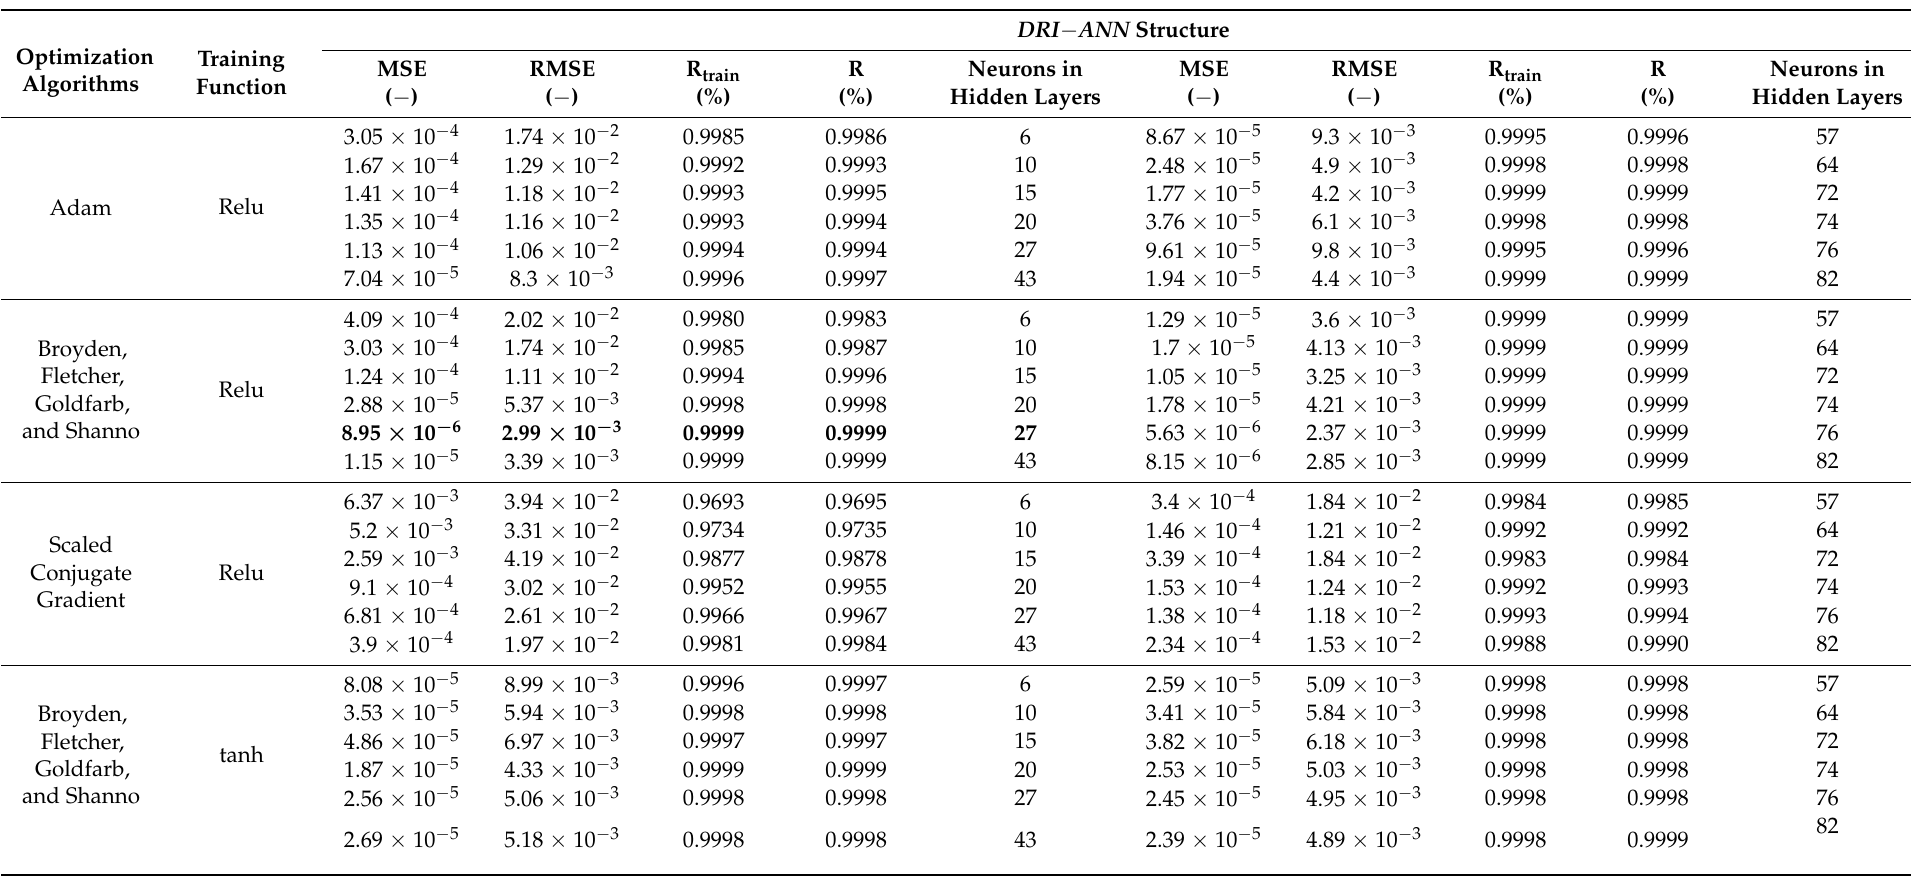
Table 4. Accuracy prediction of DRI ANN structures using MLP model algorithms with learning rate = 0.02, momentum = 0.9, and batch size =